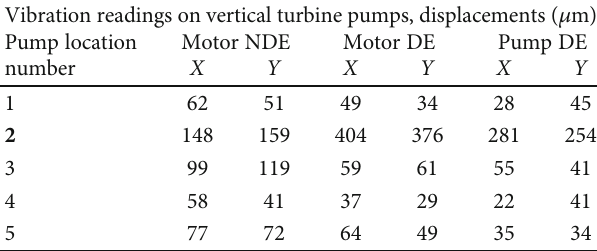
Table 1: Test data of vibration